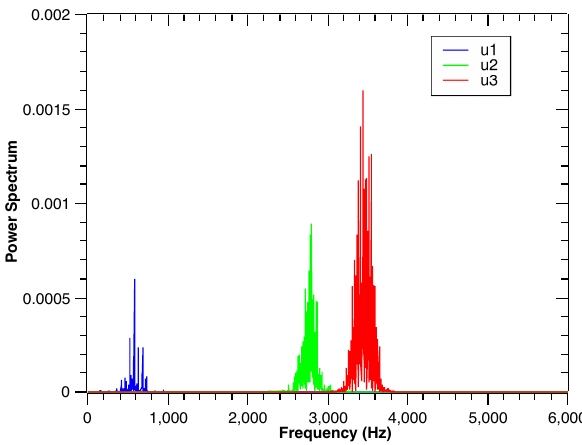
Figure 4. The time domain waveforms of rolling bearing vibration signal under the outer race defect after the variational mode decomposition (VMD) process.